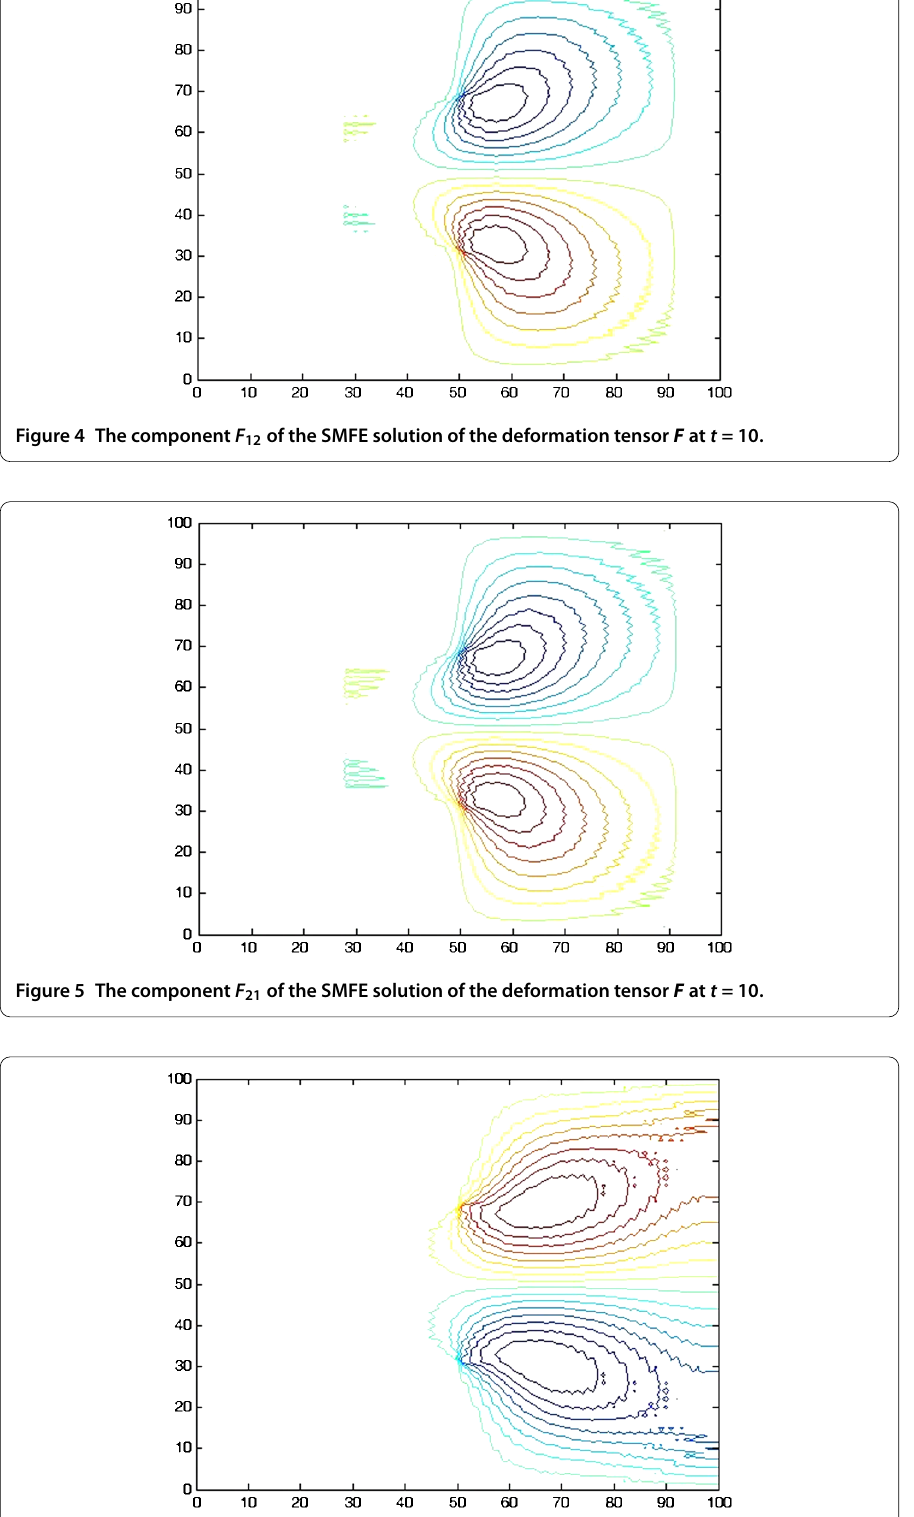
Figure 6 The component F 22 of the SMFE solution of the deformation tensor F at t =